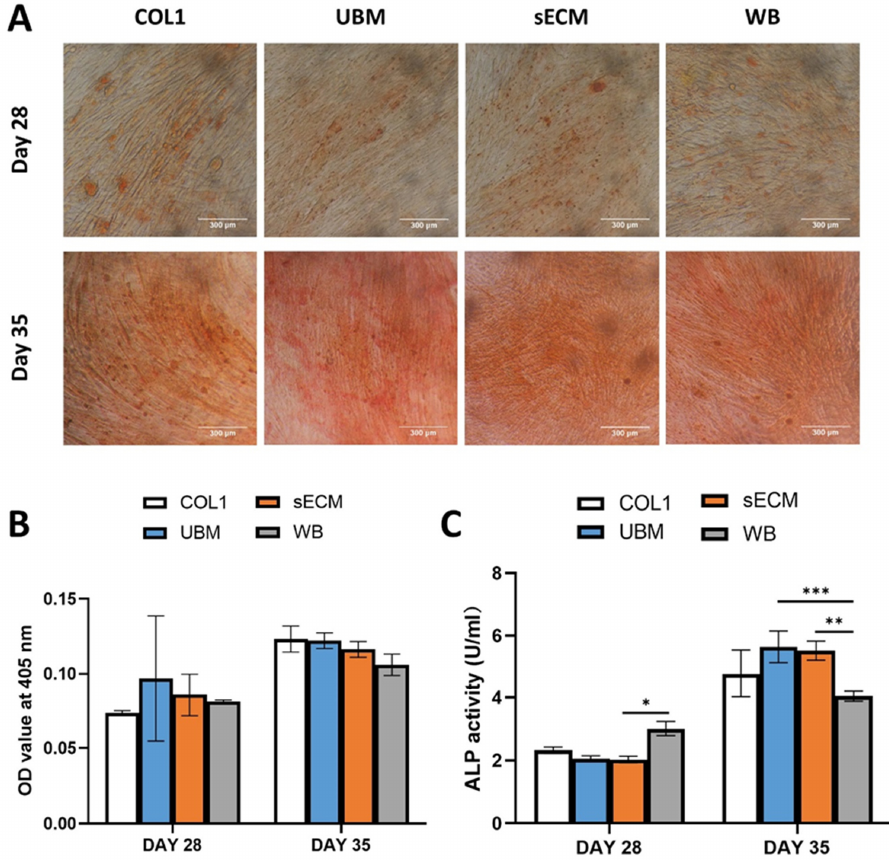
Figure 8. C2C12 differentiation after 28 and 35 days in ODM medium. ( A ) Representative images of cells stained with Alizarin red. ( B ) Calcium content quantified by spectrophotometer ( n = 3). ( C ) ALP activity measurement by spectrophotometer ( n = 3). *, **, *** denote statistical difference within the same group with p < 0.05, 0.01, 0.001, respectively ( n = 3).